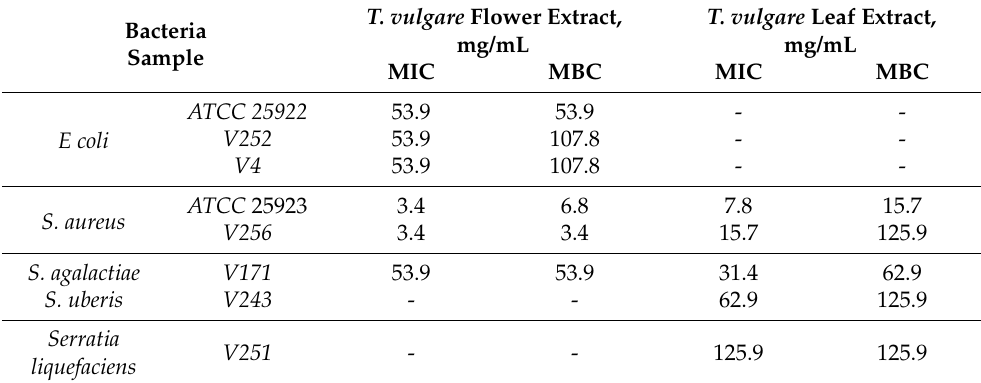
Table 3. Minimal Inhibitory Concentration and Minimal Bactericidal Concentration of T. vulgare extracts by the Broth Microdilution